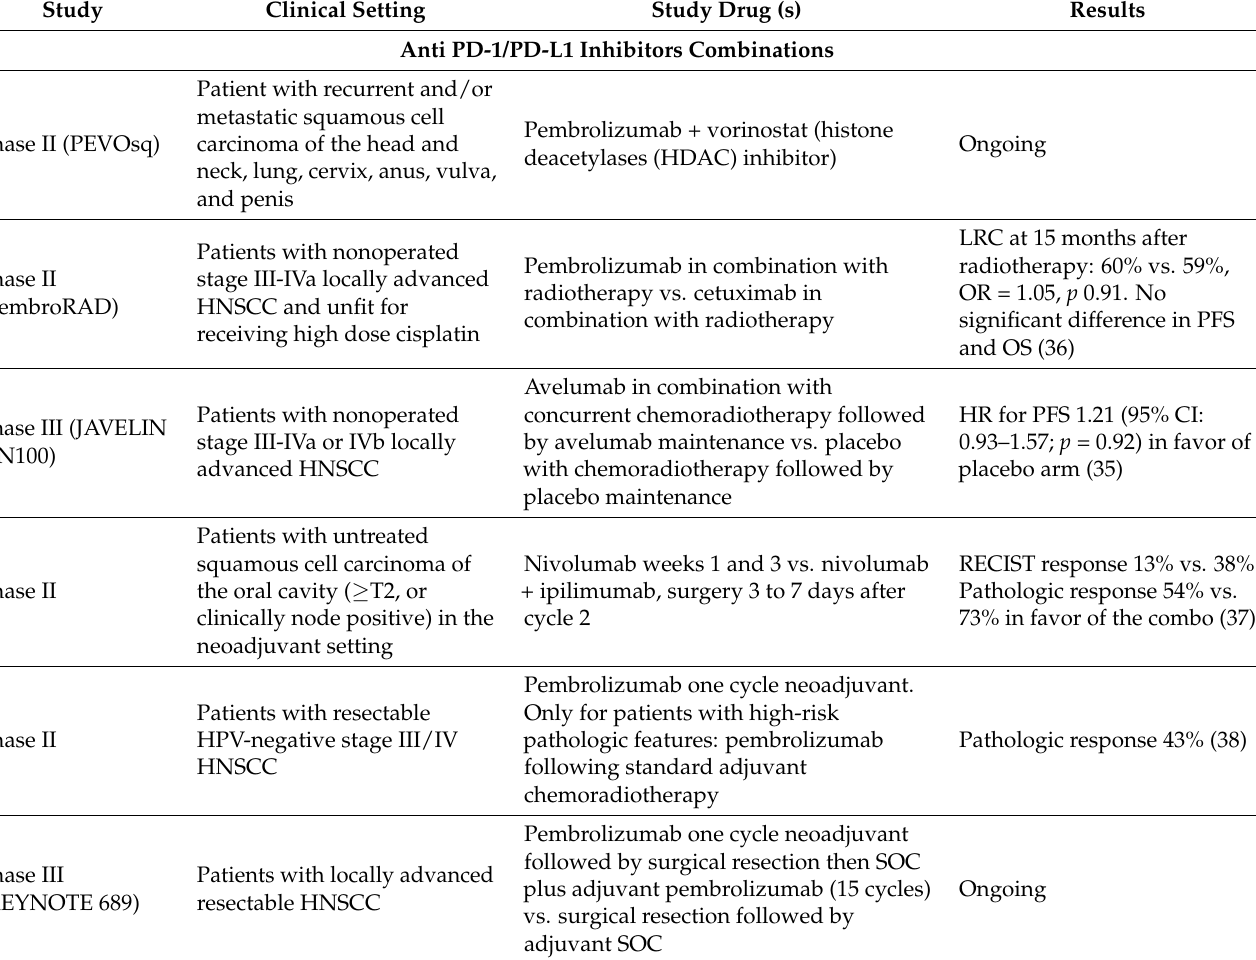
Table 2. Future perspectives of immunotherapies in the treatment of HNSCC